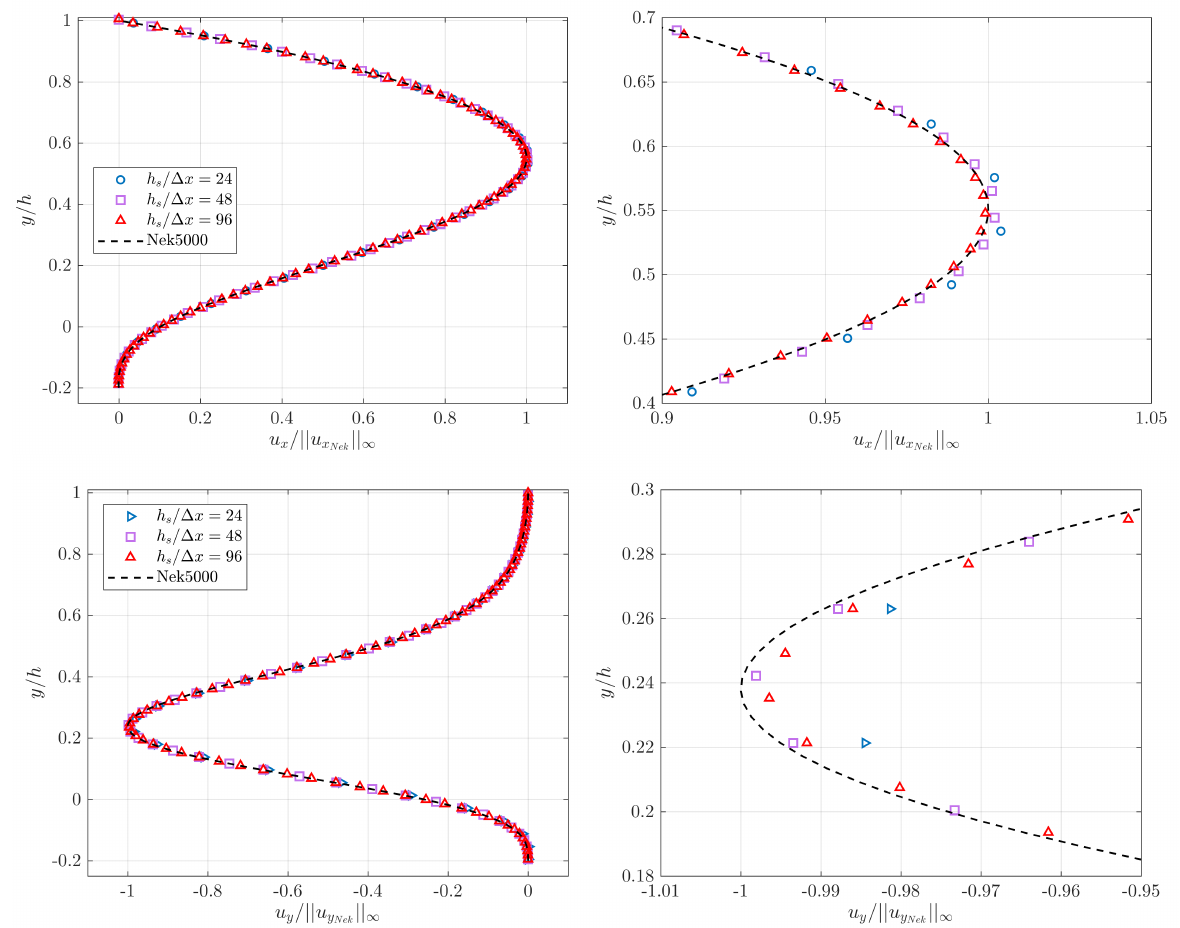
Figure 17. Profiles of u x , u y and u z for h / ∆ x = 24,48,96 along the wall-normal direction, profile set at ( x 2 , z 2 )